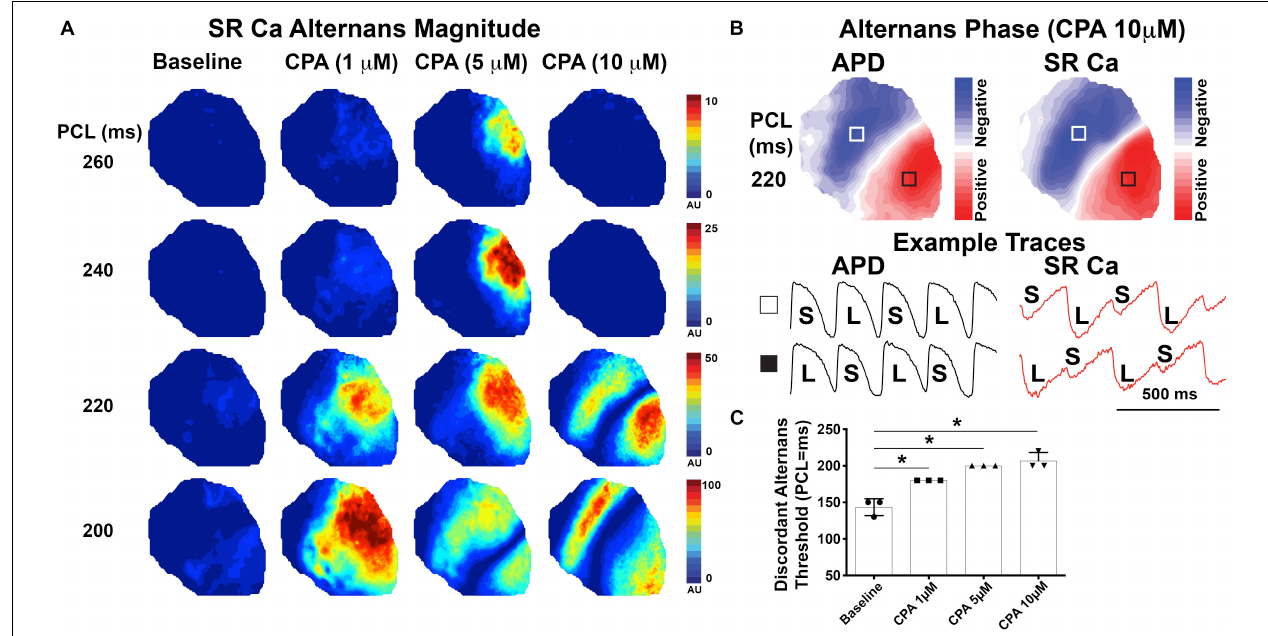
FIGURE 5 | Inhibition of sarco-endoplasmic reticulum Ca 2 + -ATPase (SERCA) with cyclopiazonic acid (CPA) promoted the emergence of spatially discordant alternans at slower pacing cycle lengths (PCL). (A) Magnitude of sarcoplasmic reticulum (SR) Ca 2 + alternans at progressively faster PCLs. Spatial discordance emerges at 220-ms PCL for 10 µ M of CPA and at 200-ms PCL for 5 µ M CPA, while baseline and 1 µ M of CPA remain spatially concordant over the PCLs shown. (B) Alternans phase with the nodal line indicated in white where alternans transitions from small:large to large:small. Optical V m and SR Ca 2 + traces are from the regions indicated with white and black boxes. (C) Pacing threshold for the induction of spatial discordance was significantly increased with CPA. Mean ± SD. N = 3 (* p < 0.05 vs.